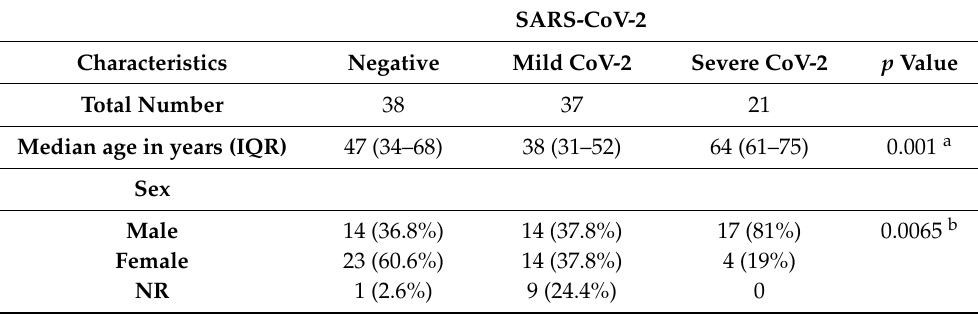
Table 2. Demographic data of subjects whose nasopharyngeal swab samples were used.